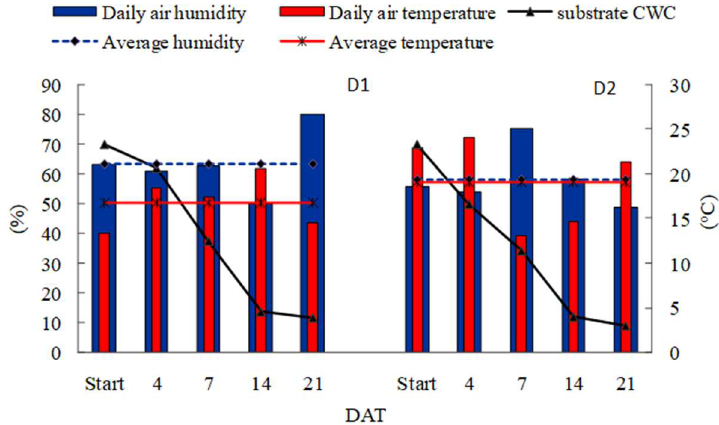
Figure 1. Average daily air humidity (%), air temperature (°C), and substrate capillary water capacity—CWC (%)—in the following days of water deficit treatment (4, 7, 14, and 21 DAT) during spring and summer droughts (D1 and D2, respectively).